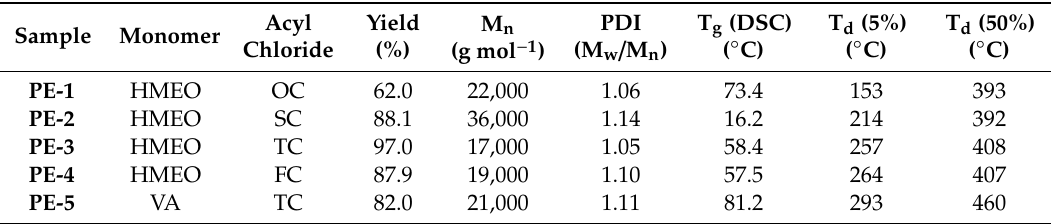
Table 1. Characterization of polyesters prepared from HMBO and vanillyl alcohol (VA) with a range of acyl